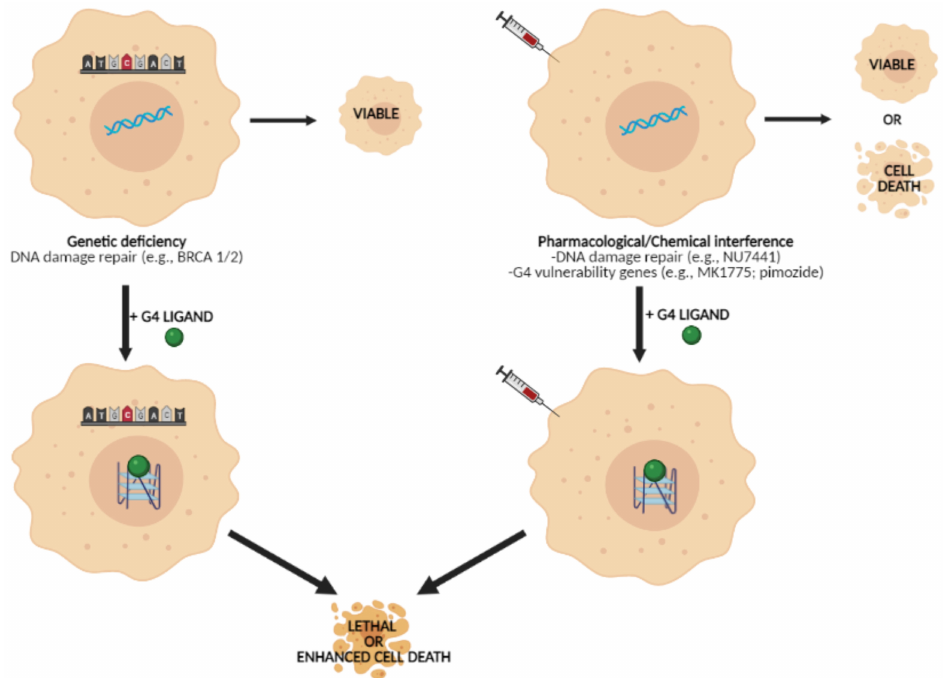
Figure 3. Schematic representation of G4 ligand-mediated synthetic lethality. In this context, the complementary treatment with a G4 ligand can be exploited to enhance killing of cancer cells characterized by specific genetic deficiency or upon pharmacological/chemical inhibition of the activity/expression of specific genes (created with